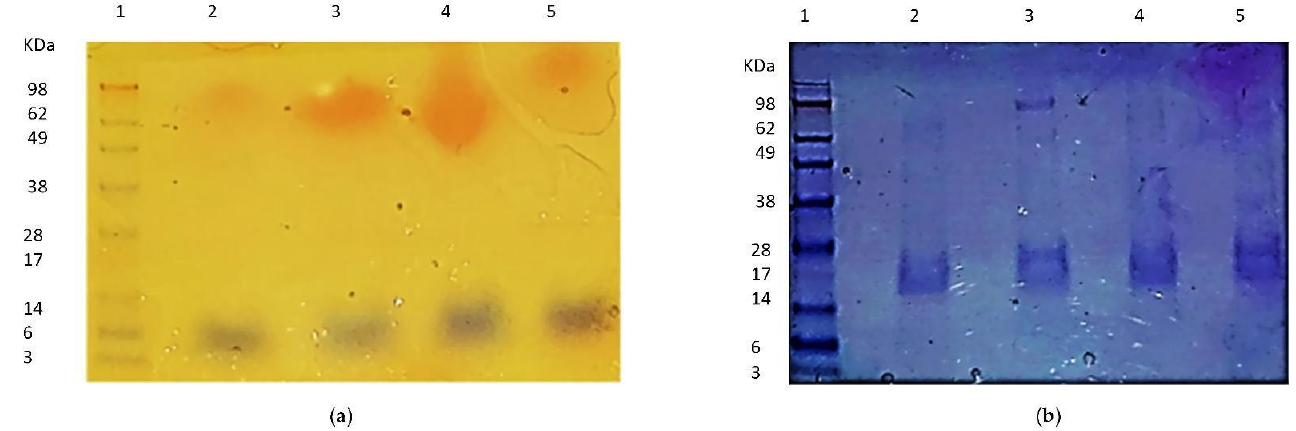
Figure 7. Electrophoresis SDS-PAGE for testing of presence of structural zinc of recombinant MAP3773c by stain PAR. ( a ) Lane 1: molecular weight marker; lane 2: MAP3773c without β -mercaptoethanol; lane 3: MAP3773c with β -mercaptoethanol 4, MAP3773c with DTT; lane 5: MAP3773c with H 2 O 2 . ( b ) The same gel as A, stained with Coomassie blue.